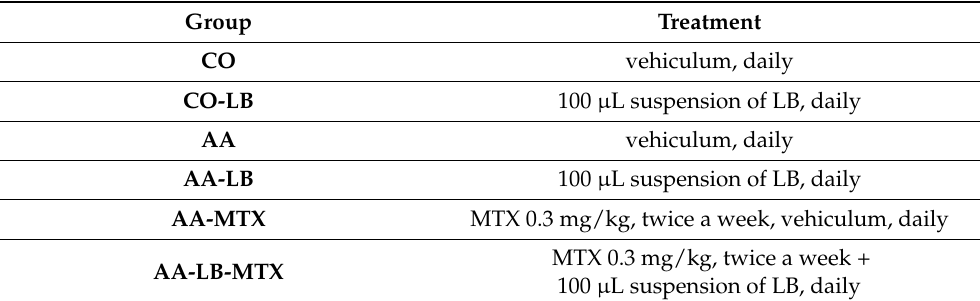
Table 1. Experimental design of animal groups with their treatment. Group Treatment CO vehiculum, daily CO-LB